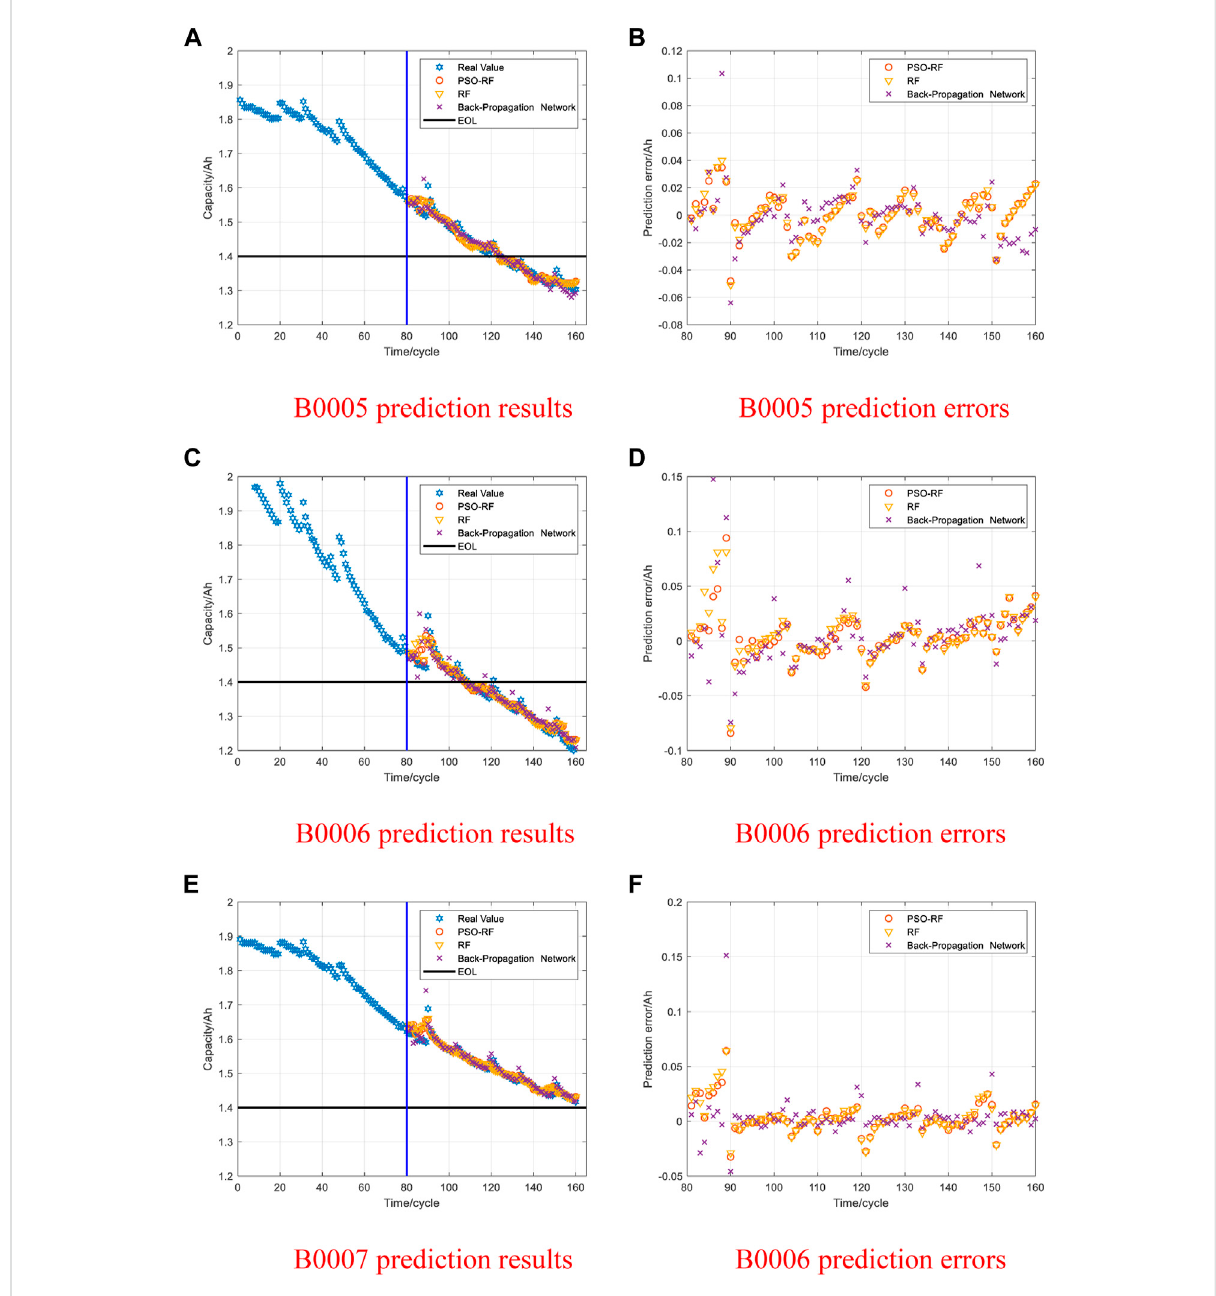
FIGURE 16 Prediction results comparison of NASA data set when prediction starting point is